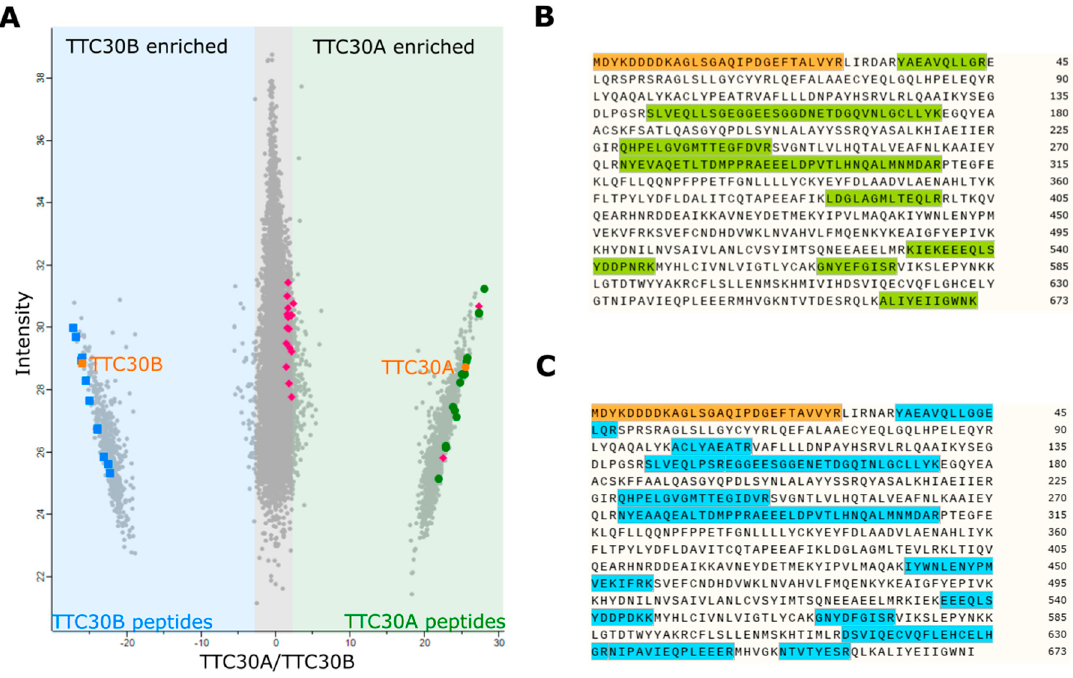
Figure 6. The scatter plot ( A ) depicts the distribution of all peptides detected. The x-axis depicts the log 2 ratios of identified peptides and the y-axis the log 2 of their respective intensities. Peptides occurring with higher abundance in TTC30A samples can be found on the right ( green ), whereas peptides with higher abundance in TTC30B samples on the left ( blue ). Peptides, which are equally abundant, can be found in the middle ( grey ). Specific and significantly enriched unique peptides are marked in green (TTC30A) and blue (TTC30B), and FLAG-tagged peptides in orange. Non-significant TTC30 peptides are marked in magenta. The amino acid sequences illustrate the specifically detected fragments of TTC30A (( B ); green ) and TTC30B (( C ); blue ) along with their FLAG-tagged peptides ( orange ) and the corresponding position in the protein sequence.